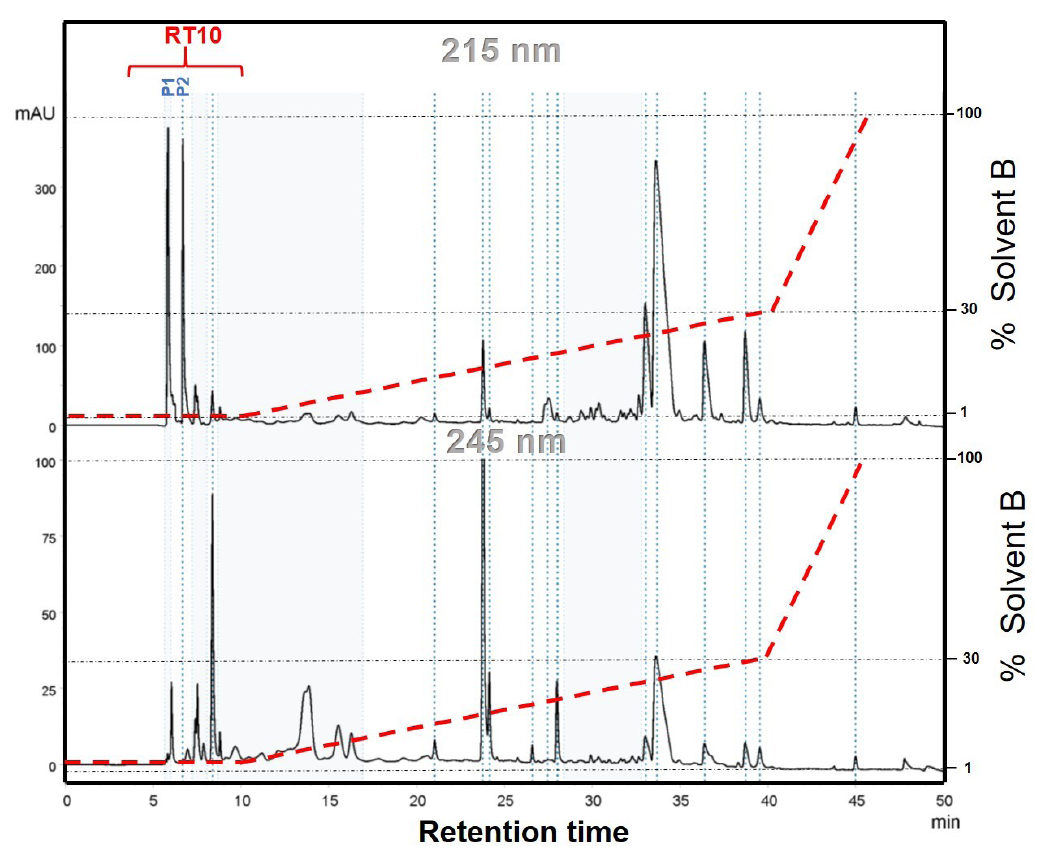
Figure 1. Representative chromatogram of the fractionation of P. bistriata spider venom in high-performance liquid chromatography (HPLC), with linear gradient of solvent B (Acetonitrile) from 1 to 100%. Flow rate in 8.0 ml/min and eluents monitored and recorded at 215 nm and 245 nm. RT10= fraction studied in this work. P1=Parawixin1; P2=Parawixin2.